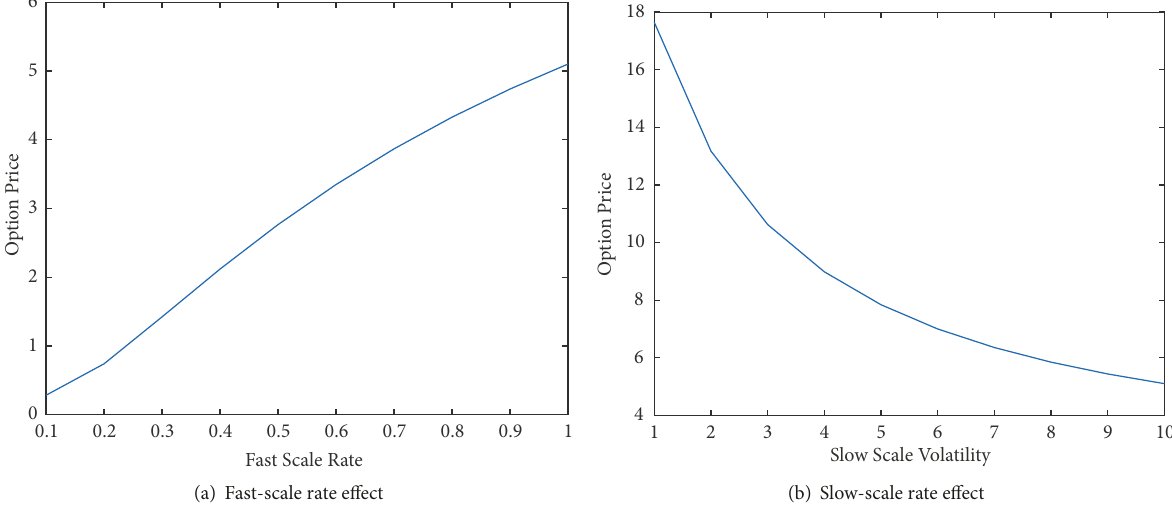
Figure 6: The effect of jump intensity rate 𝜆 .